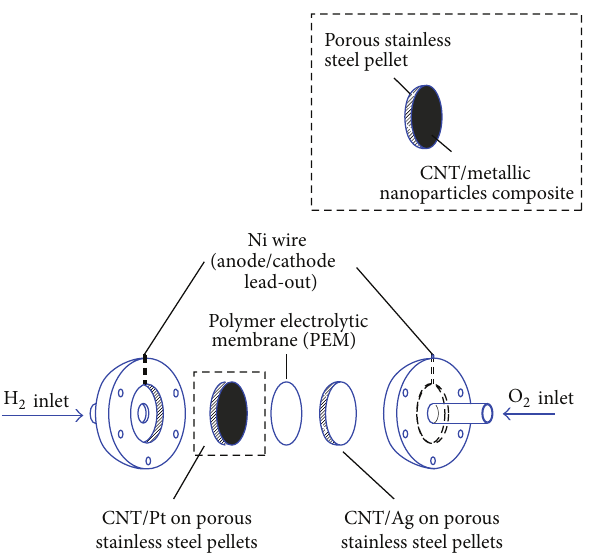
Figure 4: Laboratory model of hydrogen-oxygen fuel cell.